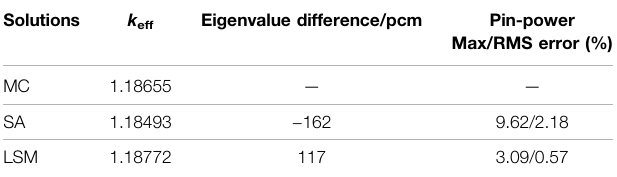
TABLE 3 | Summary of the results.